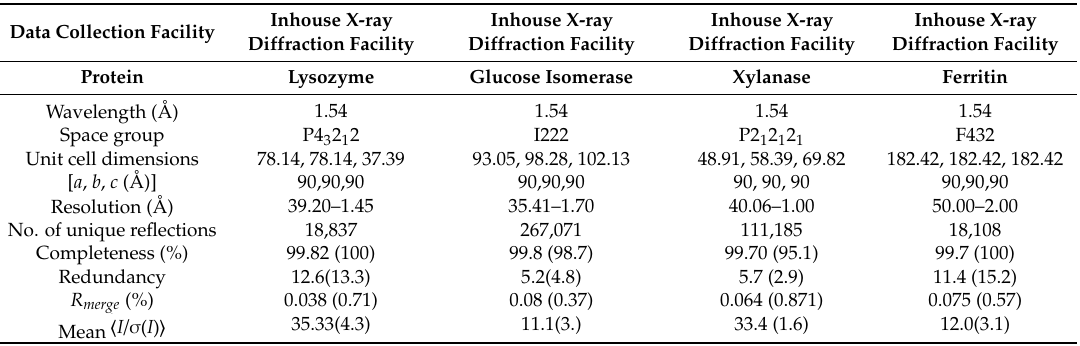
Table 1. Data collection at an in-house X-ray diffraction facility and statistics of proteins (blanks) of lysozyme, glucose isomerase, xylanase and ferritin.